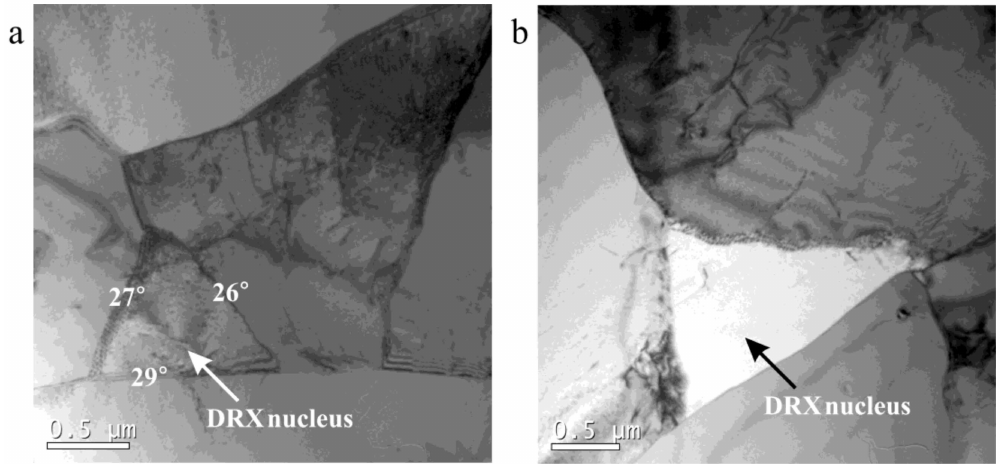
Figure 15. Dynamic recrystallization nuclei at triple junctions in 18Mn18Cr0.6N compressed to a strain of 0.8 at different cooling rates: ( a ) 0.0125 Ks − 1 ; ( b ) 0.025 Ks −